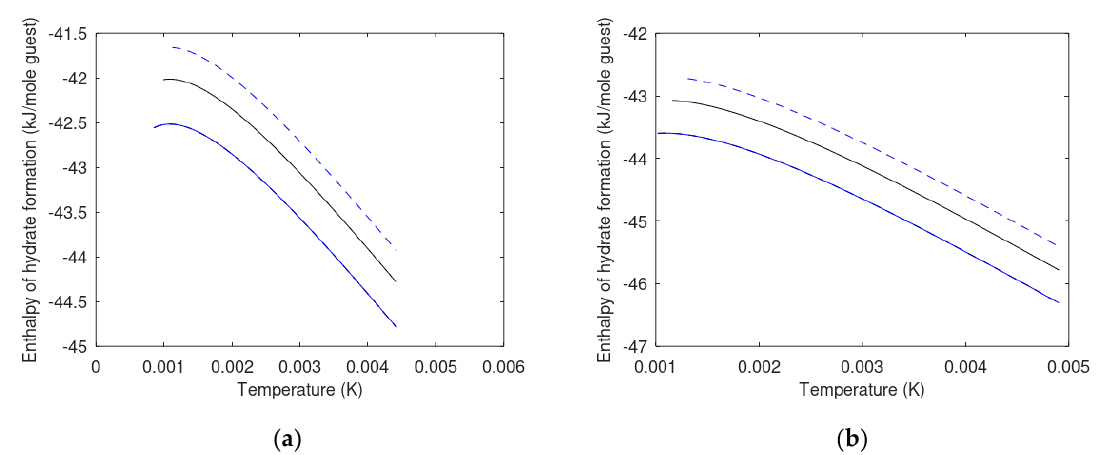
Figure 12. Enthalpies for hydrate formation (vertical axis) from dissolved methane at two conditions. ( a ) Temperature 273.16 K and pressure 200 bar. Black solid curve is for pure water and CH 4 . CH 4 solubility mole-fraction in water is 4.42 × 10 − 3 and hydrate stability limit is 8.40 × 10 − 4 . Solid blue curve is for 3 mole percent ethanol. CH 4 solubility mole-fraction in water is 4.42 × 10 − 3 and hydrate stability limit is 9.90 × 10 − 4 . Dashed curve is for 3 mole percent methanol. CH 4 solubility mole-fraction in water is 4.42 × 10 − 3 and hydrate stability limit is 1.12 × 10 − 3 . ( b ) Temperature 276 K and pressure 300 bar. Black solid curve is for pure water and CH 4 . CH 4 solubility mole-fraction in water is 4.42 × 10 − 3 and hydrate stability limit is 1.02 × 10 − 3 . Solid blue curve is for 3 mole percent ethanol. CH 4 solubility mole-fraction in water is 4.92 × 10 − 3 and hydrate stability limit is 1.16 × 10 − 3 . Dashed curve is for 3 mole percent methanol. CH 4 solubility mole-fraction in water is 4.92 × 10 − 3 and hydrate stability limit is 1.31 × 10 − 3 .